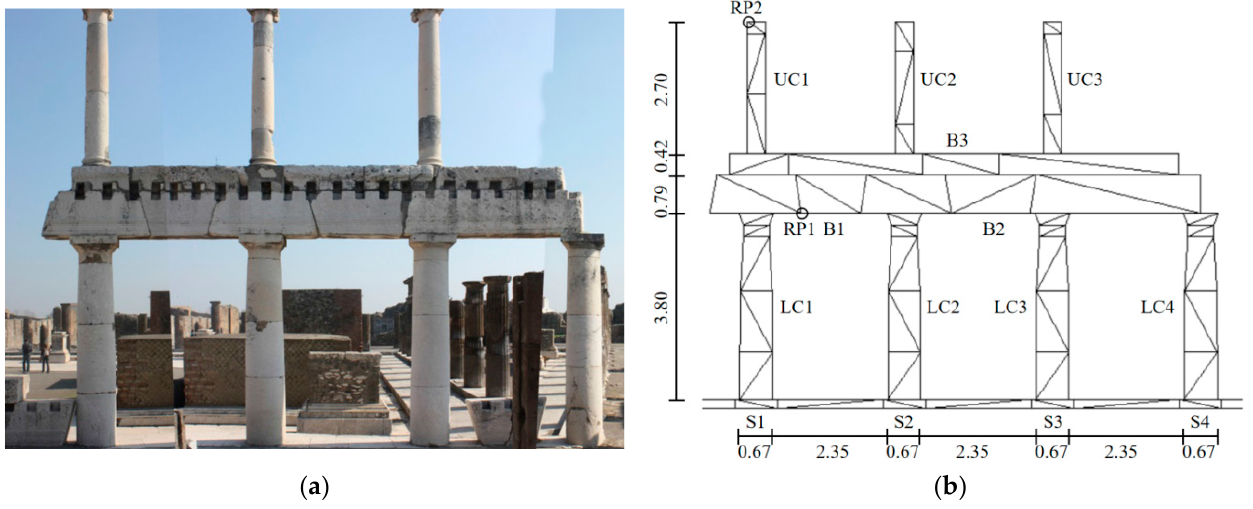
Figure 8. Remains of Forum in Pompeii: ( a ) site view [20] (Reprinted/adapted with permission from Ref. [20]. 2022, Springer Nature.) and ( b ) geometry (unit: m) and FDEM mesh. Table 2. Material properties of the